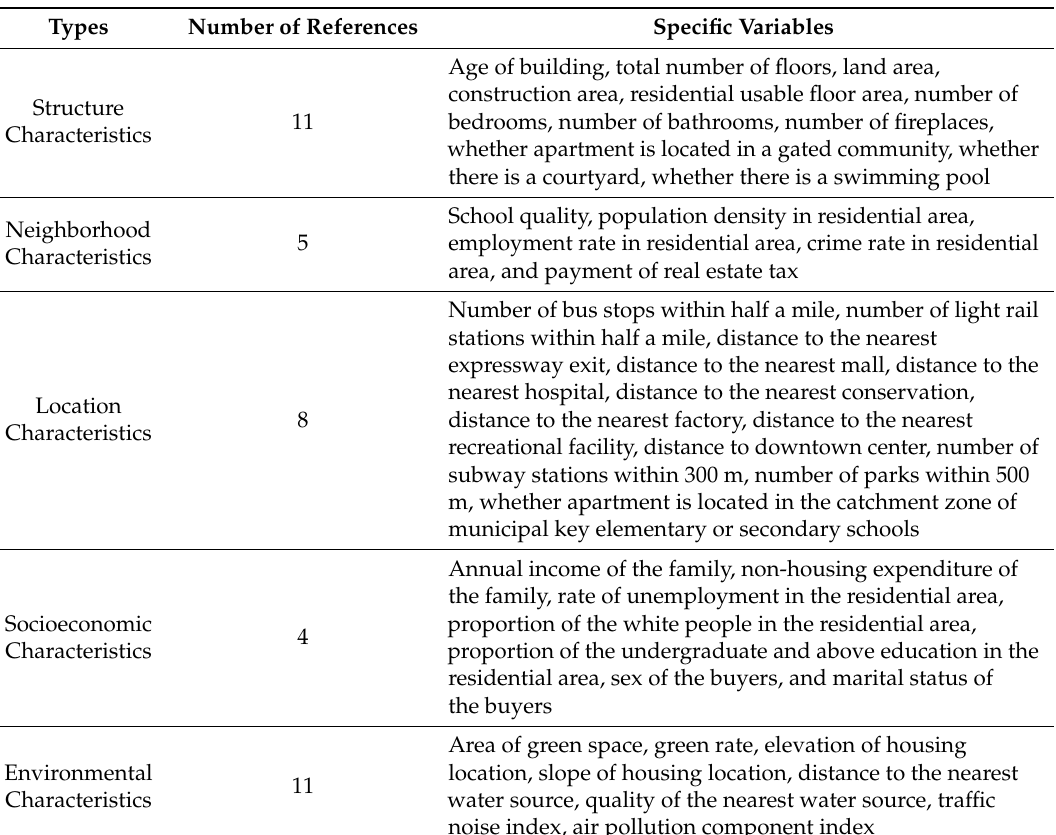
Table 1. Results from the existing